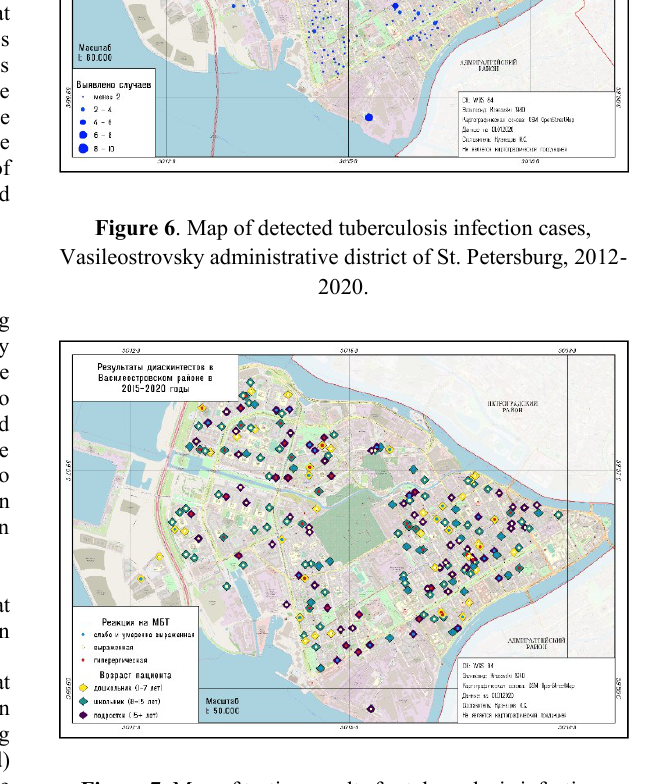
Figure 7 . Map of testing results for tuberculosis